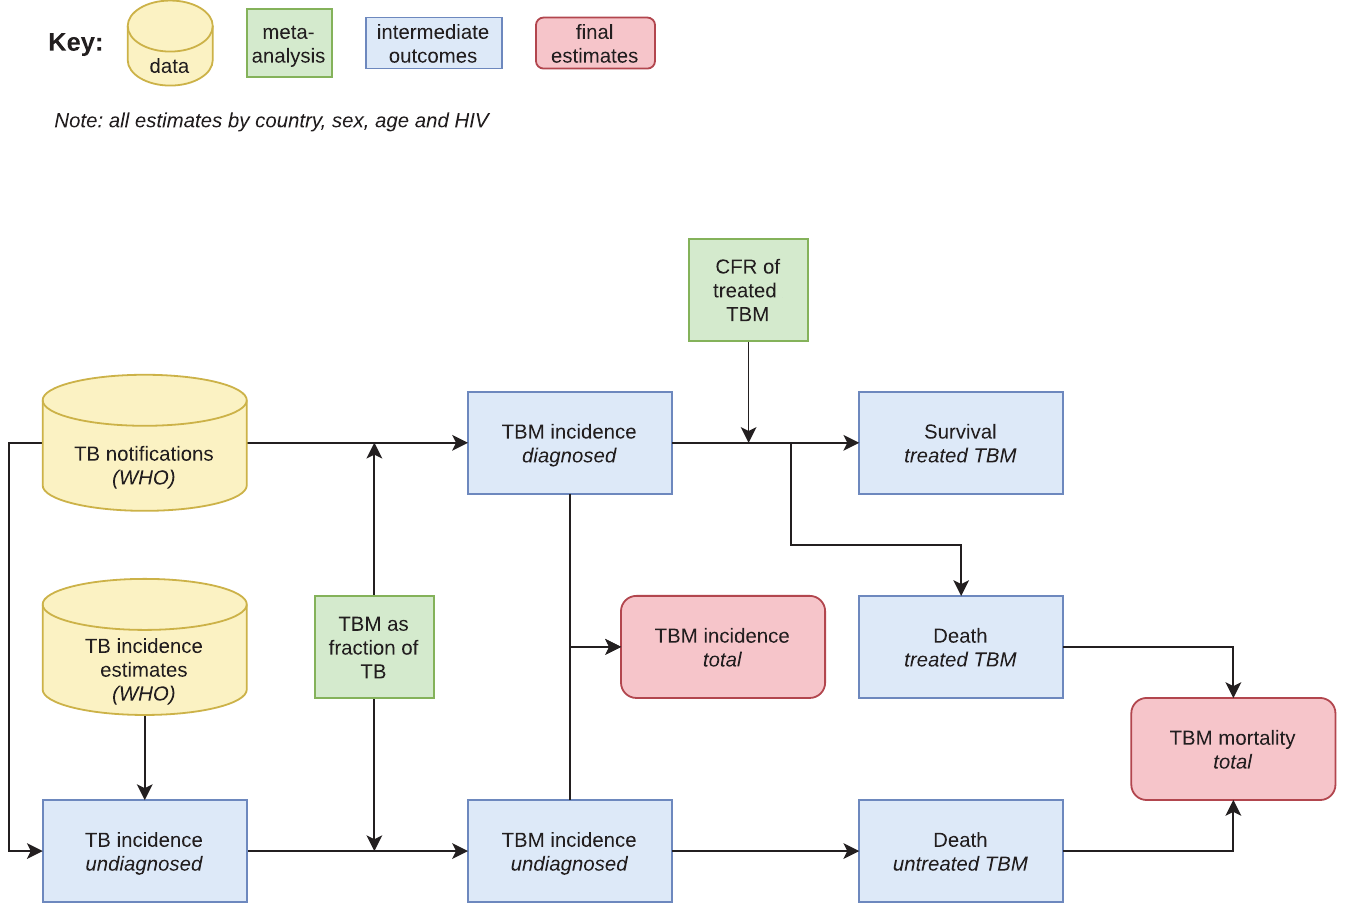
Fig 1. Flow chart of overall methods. TB: tuberculosis; TBM: tuberculous meningitis; CRF: Case fatality Rate; WHO: World Health